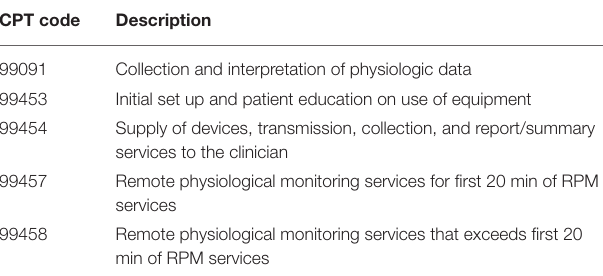
TABLE 2 | Current procedural terminology (CPT) codes for reimbursement of RPM services.